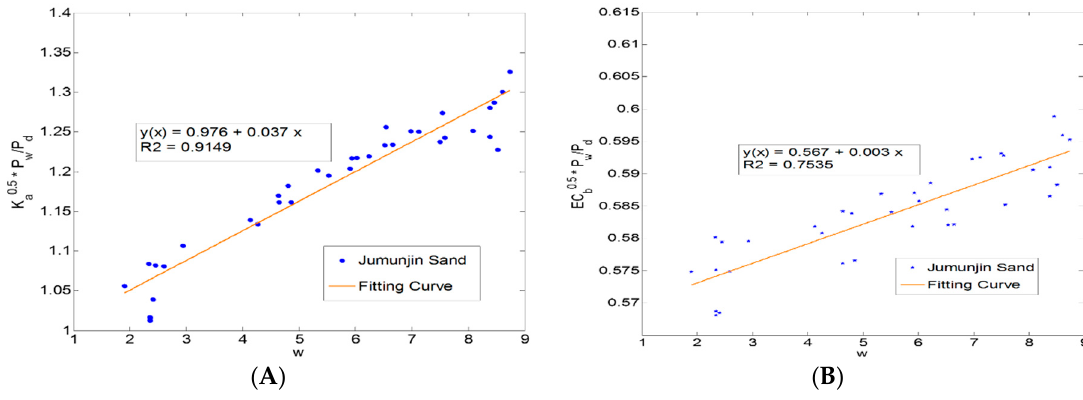
Figure 17. Calibration curve to obtain soil constants for Jumunjin Sand. ( A ) a, b; ( B ) c, d.